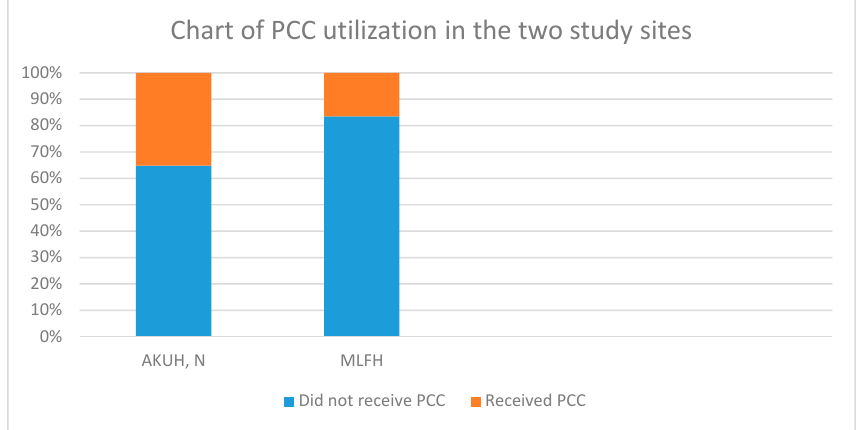
Figure 1. Preconception care (PCC) utilization in the two study sites.